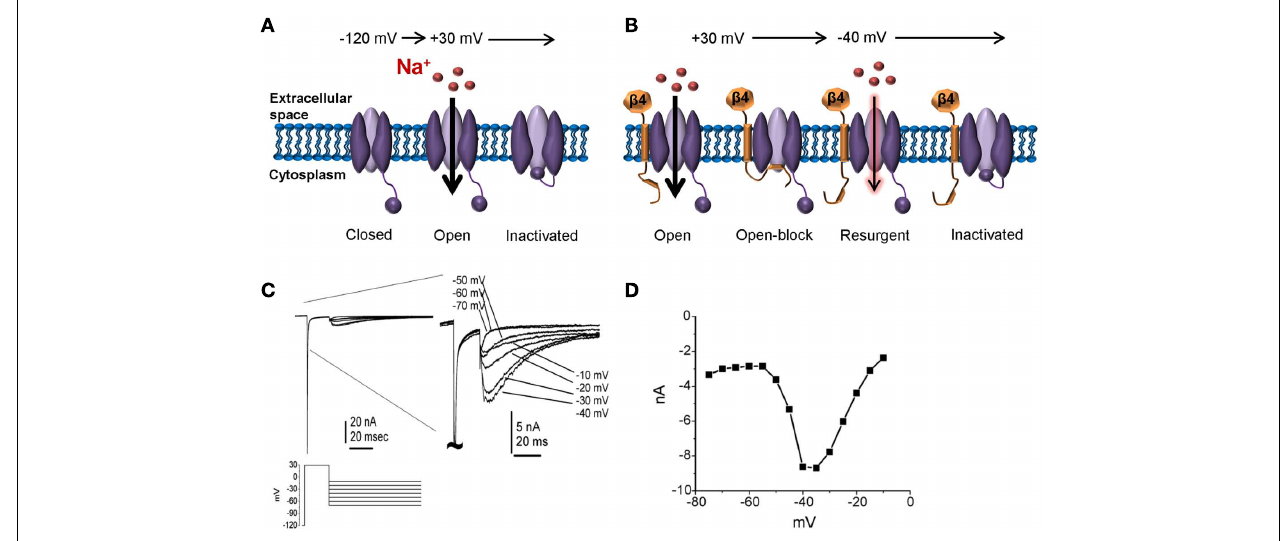
resulting in open-channel block. Following a hyperpolarization to an intermediate potential, the blocker is expelled resulting in an additional surge in current. (C) Representative resurgent sodium currents recorded from a large Nav1.8-null DRG neuron.The traces are magnified in the right panel to better see the resurgent currents. (D) The voltage-dependence of the resurgent currents is shown by plotting the peak resurgent current amplitude against the repolarization pulse potential. (C,D) adapted from Cummins et al. (2005) with permission from FEBS Letters